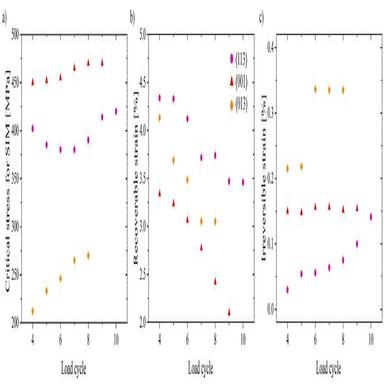
Degradation of compressive specimens with 〈113〉, 〈001〉 and 〈013〉 orientation. (a) Critical stress for SIM vs. load cycle. (b) Recoverable strain vs. load cycle. (c) Irreversible strain vs. load cycle.